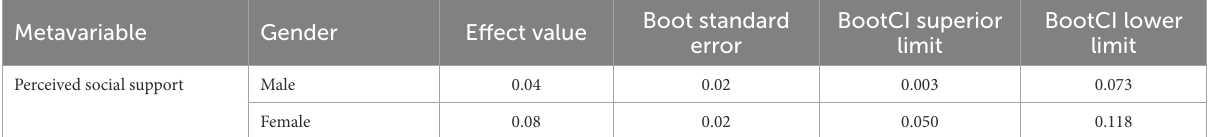
To understand the essence of the interaction effect between perceived social support and gender, male and female subjects were analyzed separately, and the mediated effect values and 95% Bootstrap confidence intervals of perceived social support between meaning in life and self-control for both groups are shown in Table